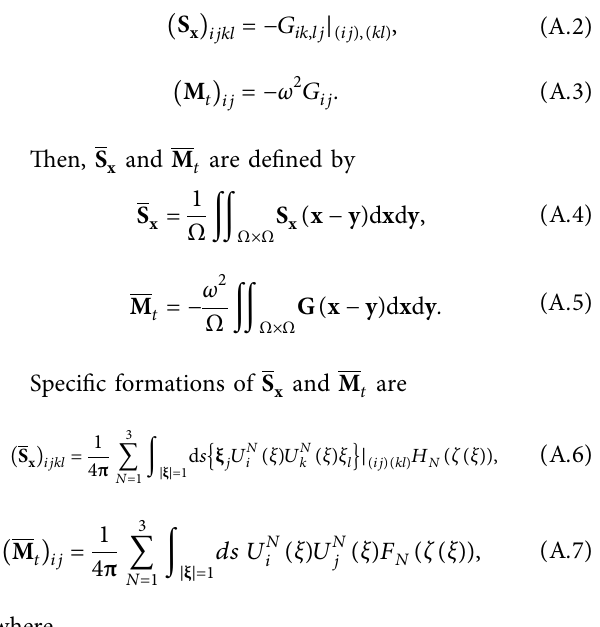
, L , L , and L are obtained by the differential method 1111 1122 1133 3333